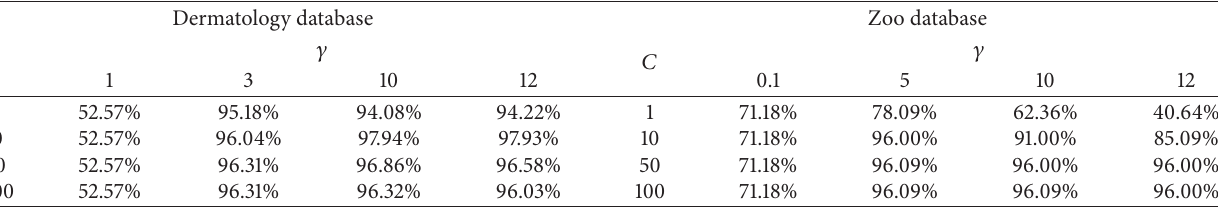
Table 4: Classification accuracy comparison.